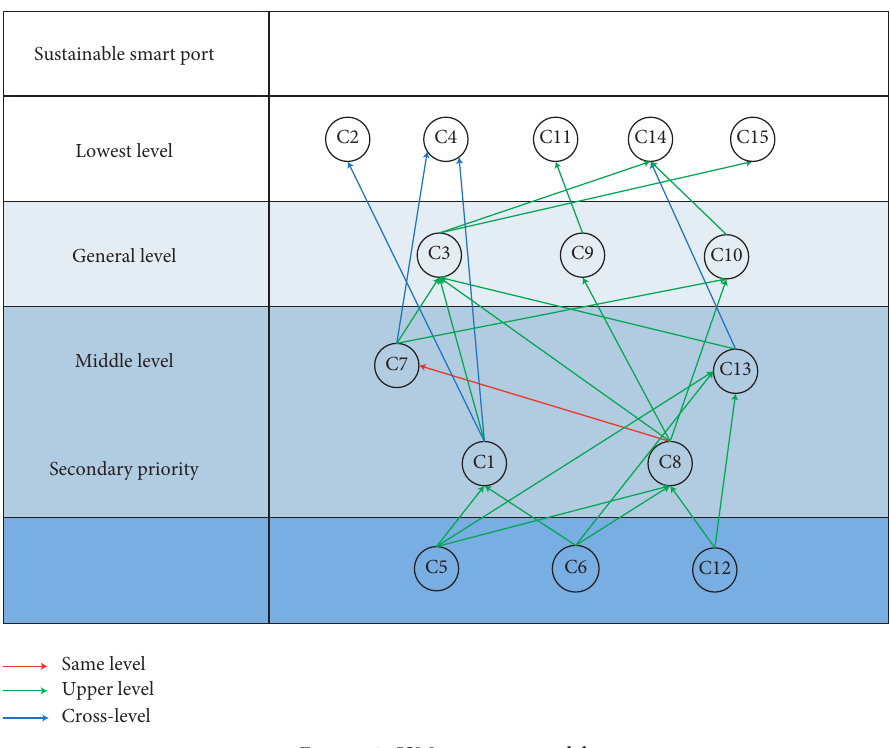
Figure 2: ISM structure